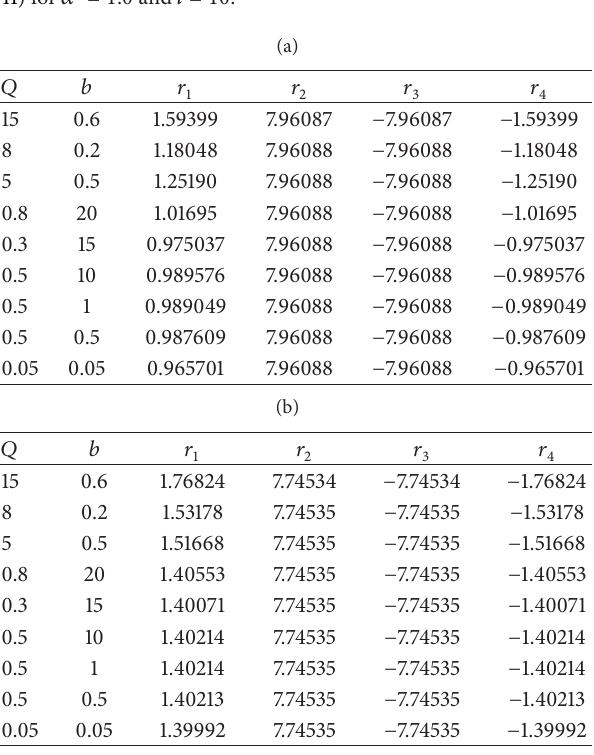
Table 1: (a) Real roots (41) for 𝛼 󸀠 = 0.5 and 𝑙 = 10 . (b) Real roots of